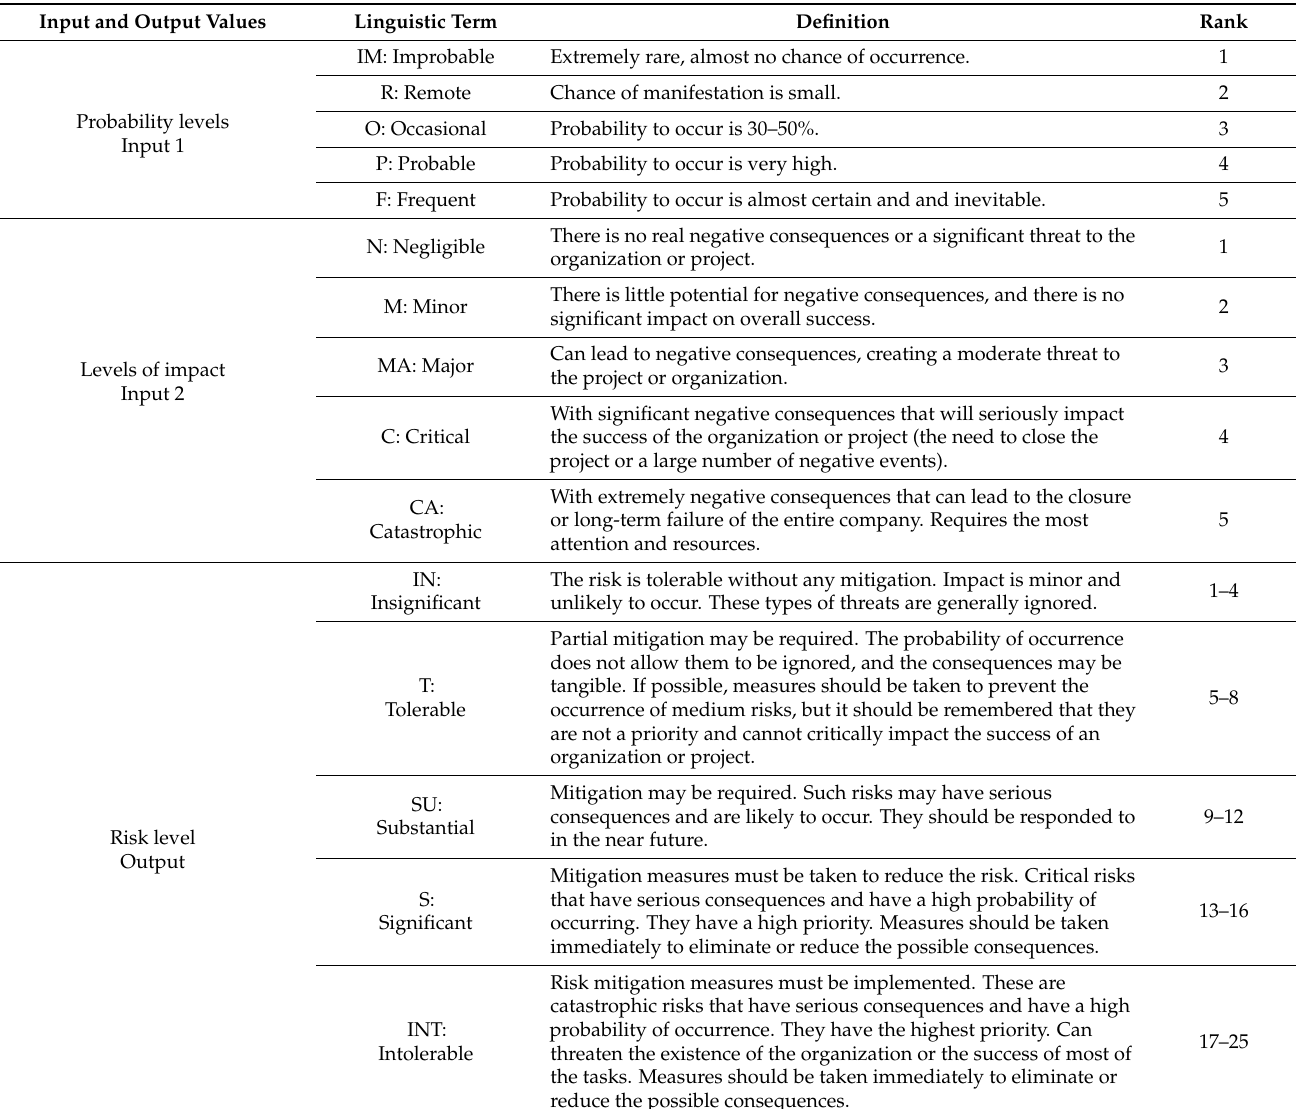
Table 1. Linguistic